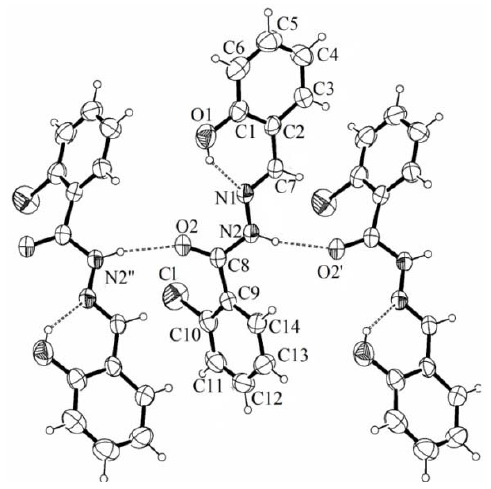
Figure 2. Molecular plot of LASSBio-466 showing the labeling scheme of the non-H atoms and their displacement ellipsoids at the 50% probability